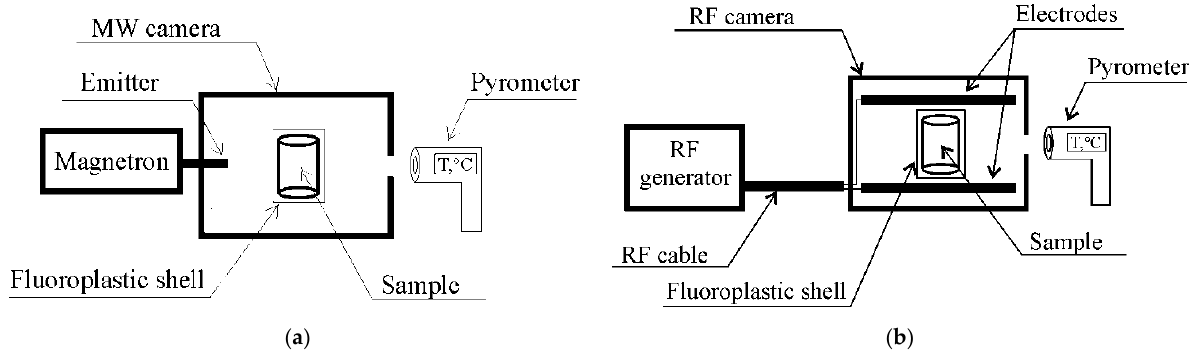
Figure 2. Schemes of experimental setups for electromagnetic influence on source rock samples in ( a ) microwave field and ( b ) radio-frequency field.